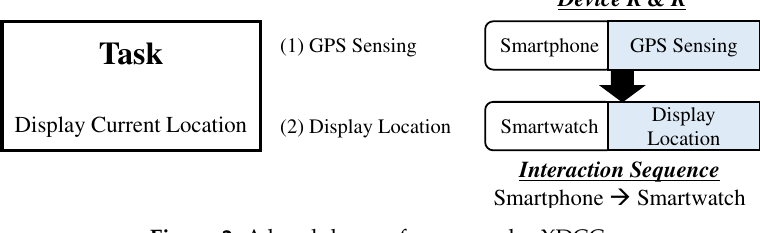
Figure 2. A breakdown of an exemplar